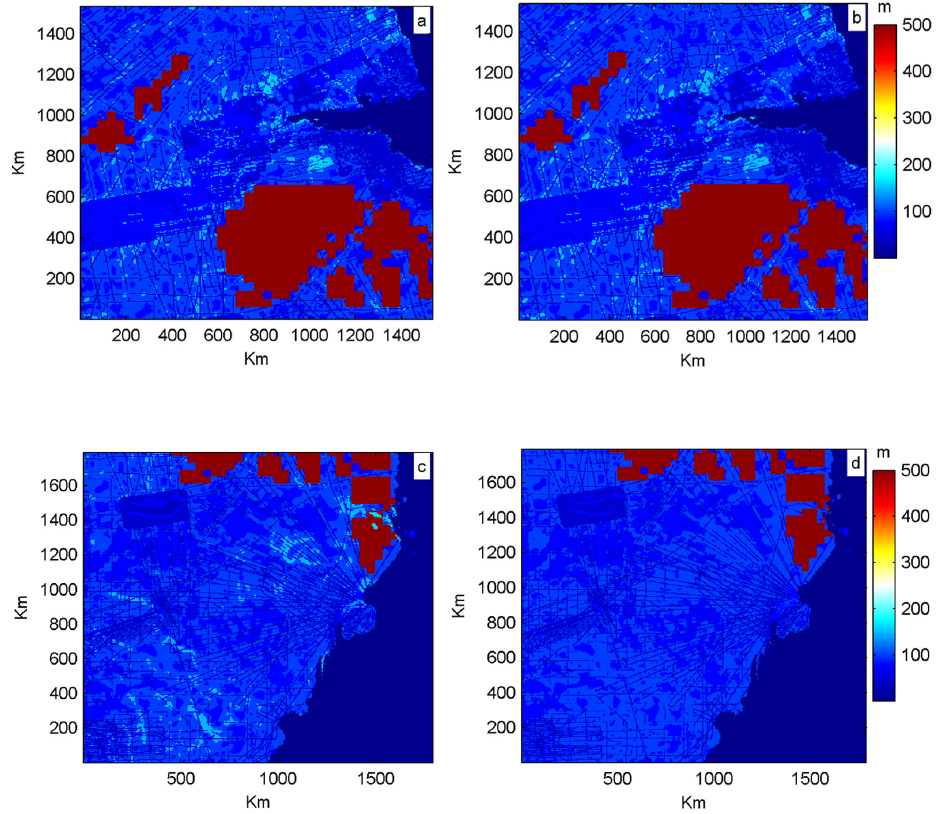
Figure 4. Comparison of uncertainty maps from Bedmap2 ( a, c ; Fretwell et al., 2013) and the one we use in the model (b,d) for the Lambert– Amery Basin (a,c) and the Aurora-Basin–Totten-Glacier region (b,d) . There are 16 single uncertainty values in Bedmap2; we combined some close values and actually use six uncertainty values. For PIG the uncertainty was uniformly 60m across the whole domain (Fig.